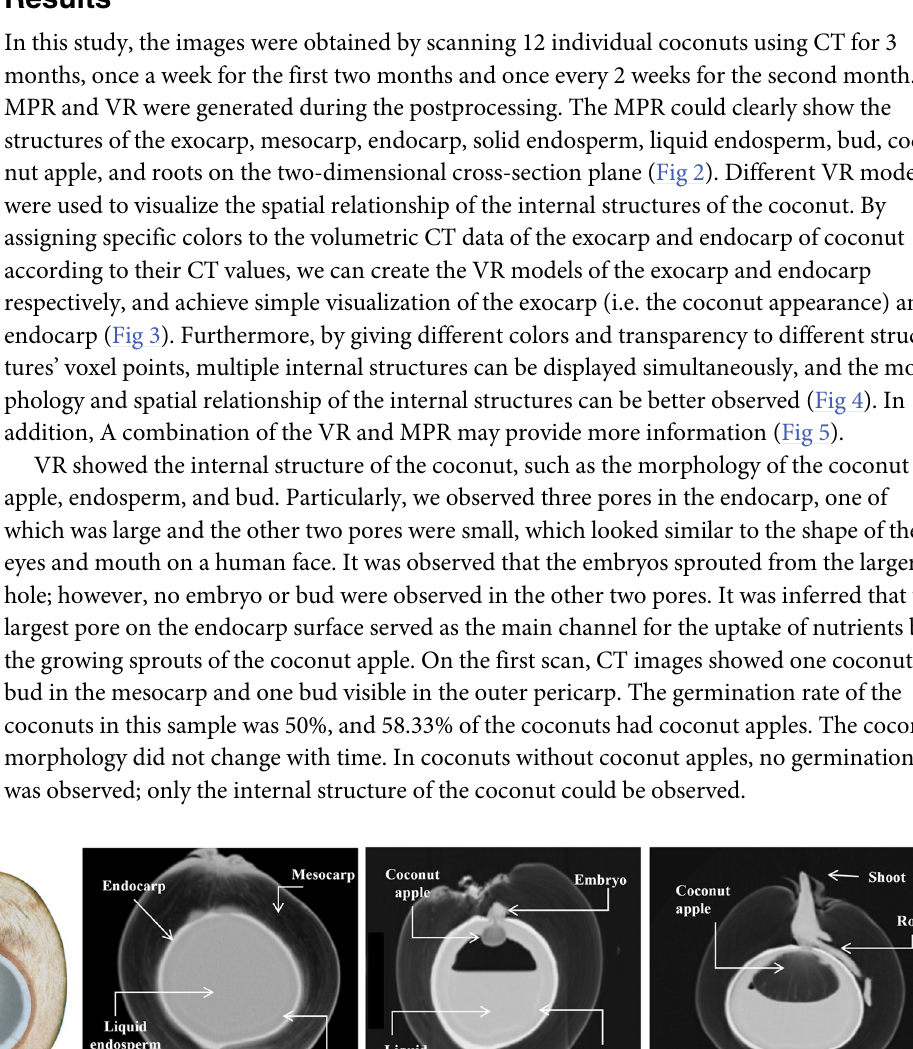
PLOS ONE | https://doi.org/10.1371/journal.pone.0282182 February 24,